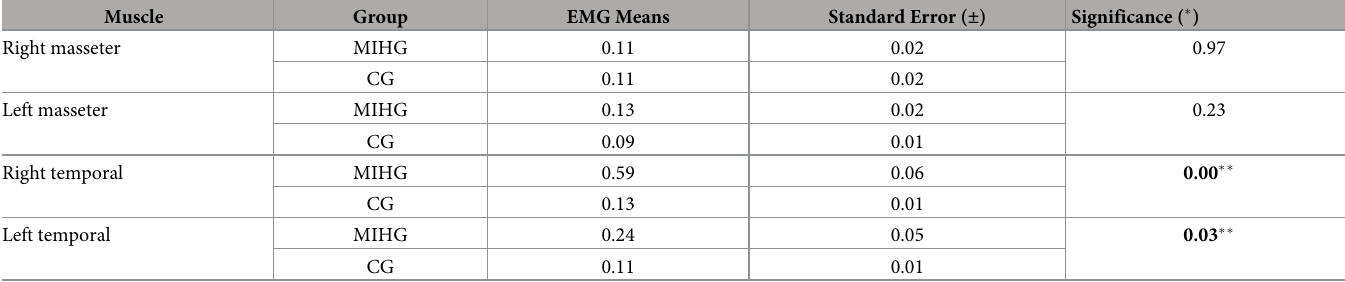
Table 3. Mean values, standard error, and statistical significance (p � 0.05) of the normalized electromyographic data in the mandibular rest condition, for each muscle evaluated, in the MIH group (MIHG) and control group (CG).